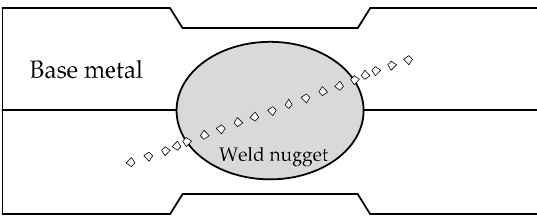
Figure 11. Schematic diagram of the microhardness measurement location of the welded joint.